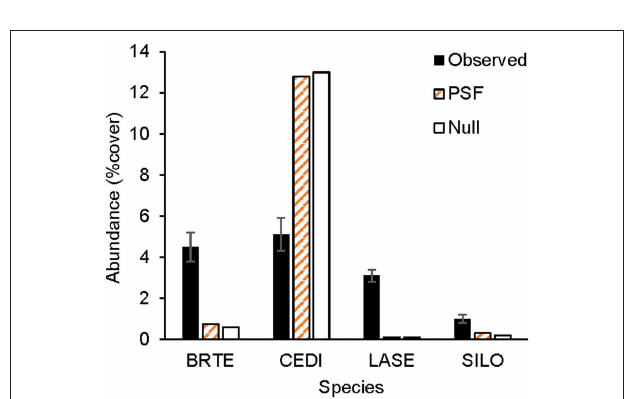
FIGURE 6 | Observed and predicted non-native plant abundance. Observed plant abundance was recorded in 25 ex-arable fields over 13 years (Kulmatiski and Beard, 2019 ). Model simulations of plant community growth for these four common non-native species were performed for a 10-year period either with plant-soil feedback data (PSF; i.e., with information on plant growth rates on different soil treatments) or with a null model (Null) which was parameterized only with plant growth rates on control soils. BRTE, Bromus tectorum ; CEDI, Centaurea diffusa ; SILO, Syssymbrium loeselii ; LASE, Lactuca serriola